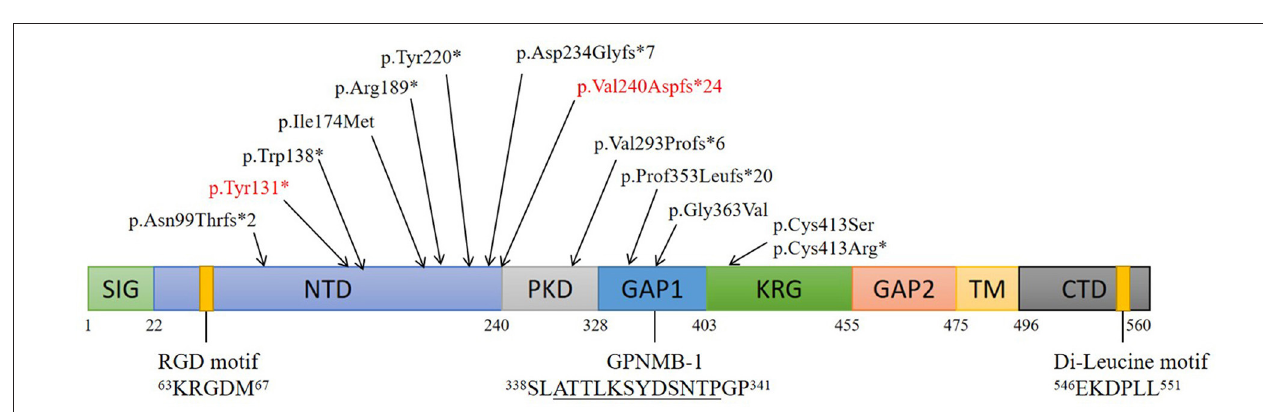
FIGURE 3 | Structure and mutations of GPNMB. Schematic of 8 domains on human GPNMB and gene mutations responsible for ACD. Numbers correspond to amino acid residues; The RGD and di-leucine motifs are shown. A splice isoform of GPNMB (GPNMB-1) with an in-frame 12-amino-acid insertion (underlined) is also shown. Locations of GPNMB mutations (on the protein) identified in this study and those from an earlier study are indicated. (SIG, signal sequence; NTD, N-terminal domain; PKD, polycystic kidney disease-like domain; KRG, kringle-like domain; TM, transmembrane domain; CTD, C-terminal cytoplasmic domain).